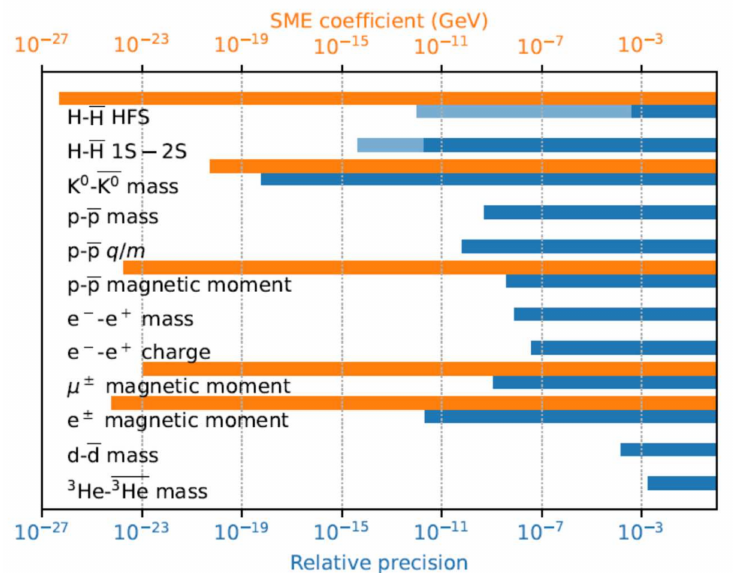
Figure 2. The relative precision of the measurements is shown against the related value of the SME coefficient. In the specific cases of mass comparison, there is no relevant SME coefficient, and the 1S-2S transition frequency is not sensitive to CPT violation. From [21] with permission from the